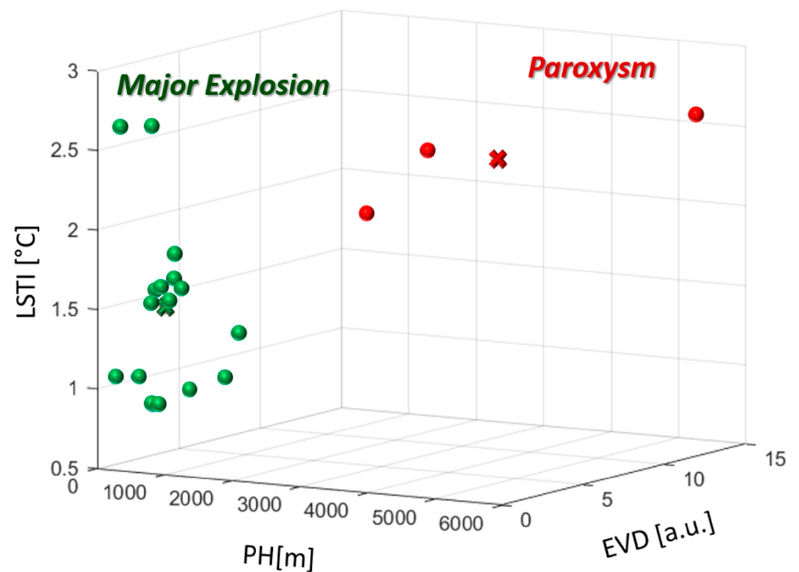
Figure 7. Classification of the eruptive events at Stromboli volcano by using k-means classifier. The dots are the input vectors for each explosive eruption, colored green if classified as Major Explosions and red if classified as Paroxysms. Centroids for each cluster are shown with a cross.